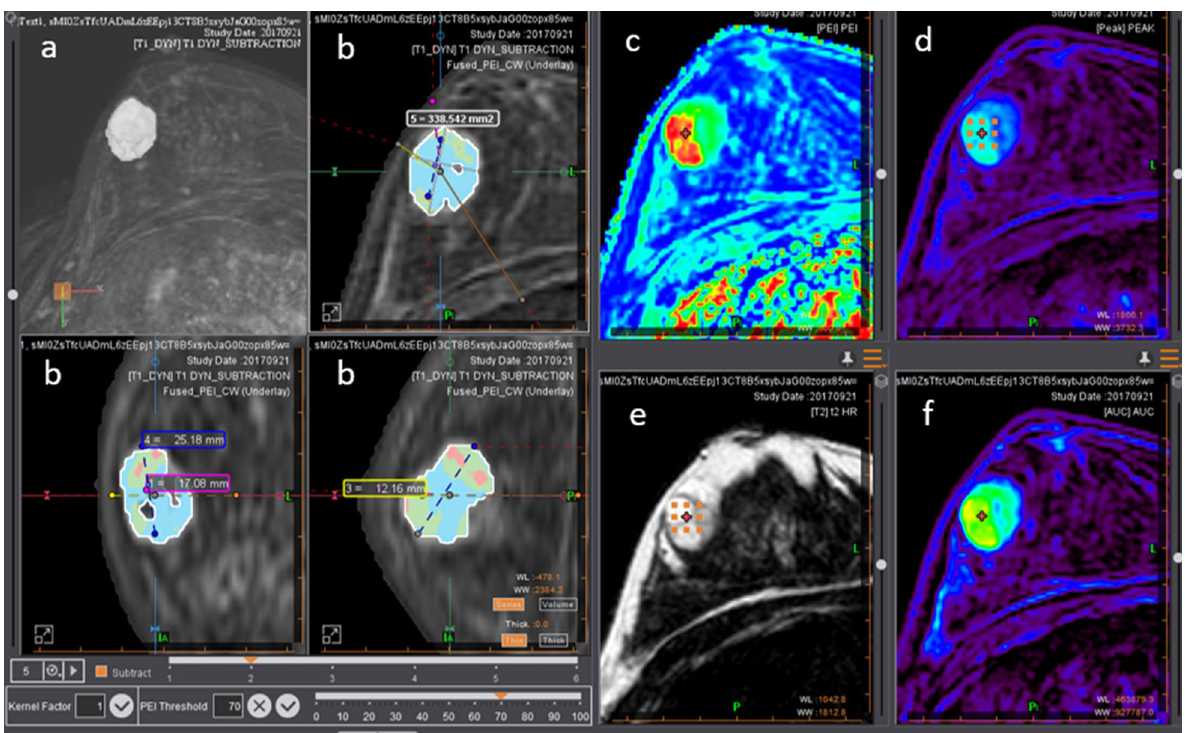
Fig. 3 Example of a fibroadenoma at the junction of the external quadrants of the right breast on the breastscape ® segmentation software: a Dynamic contrast enhancement subtraction with MIP reconstruction; b Dynamic contrast enhancement sequence merged with the PEI map in the axial, coronal, and sagittal planes; c PEI map; d PEAK map; e T2-weighted sequence in axial view; f AUC